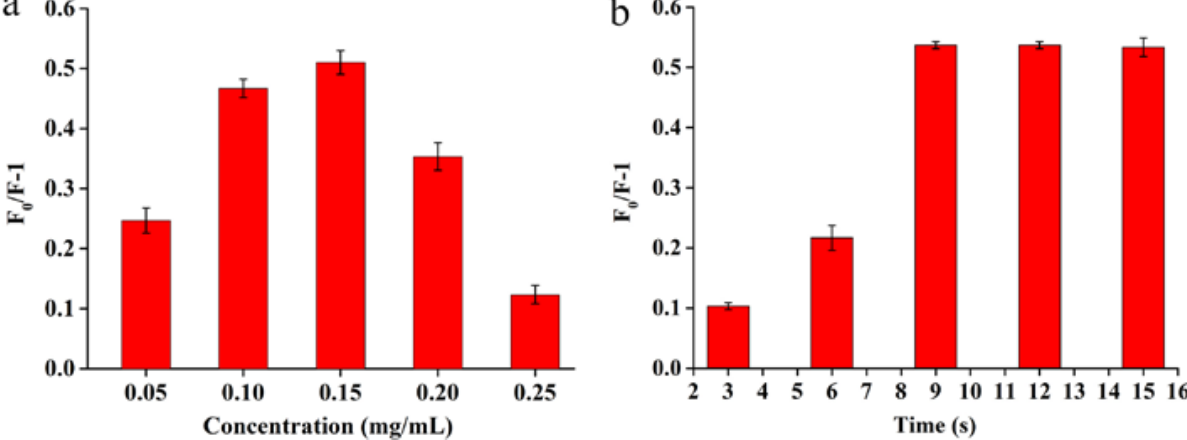
Figure 6. ( a ) Optimization of AdaPOF dichloromethane suspension concentration; ( b ) Optimization of incubation time between AdaPOF dichloromethane suspension and TC. ( λ ex = 334 nm, c = 3.0 μmol/L).